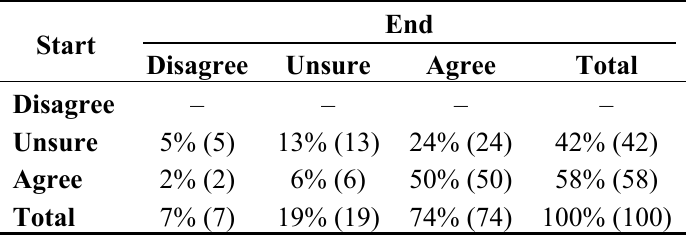
Table 2. Attitudes toward geothermal energy technology being used in